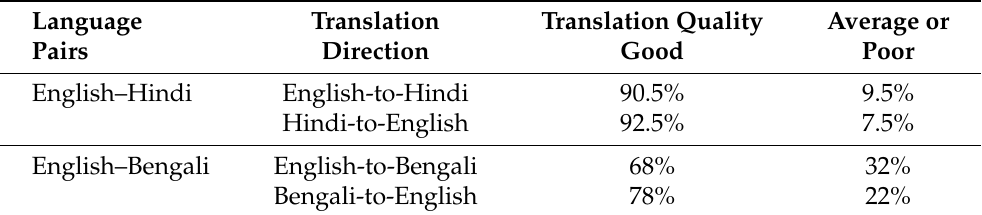
Table 7. Quality of translation outputs.